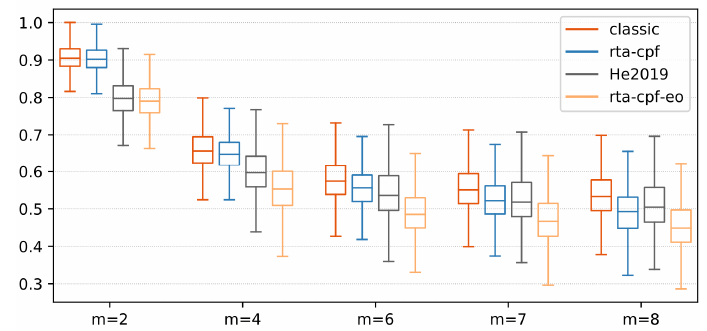
Figure 6. WC CT of DAG using different numeral of processors.